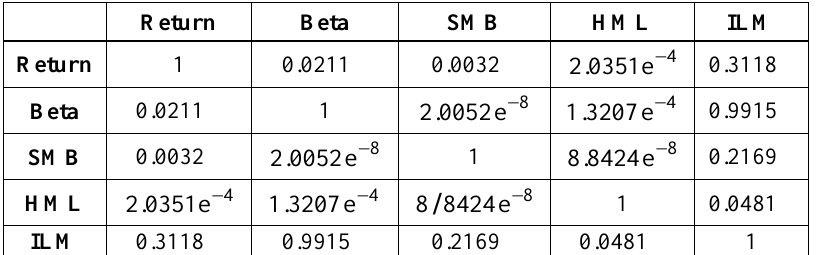
Table 4. The Probability of Significant Variables at the Third Level